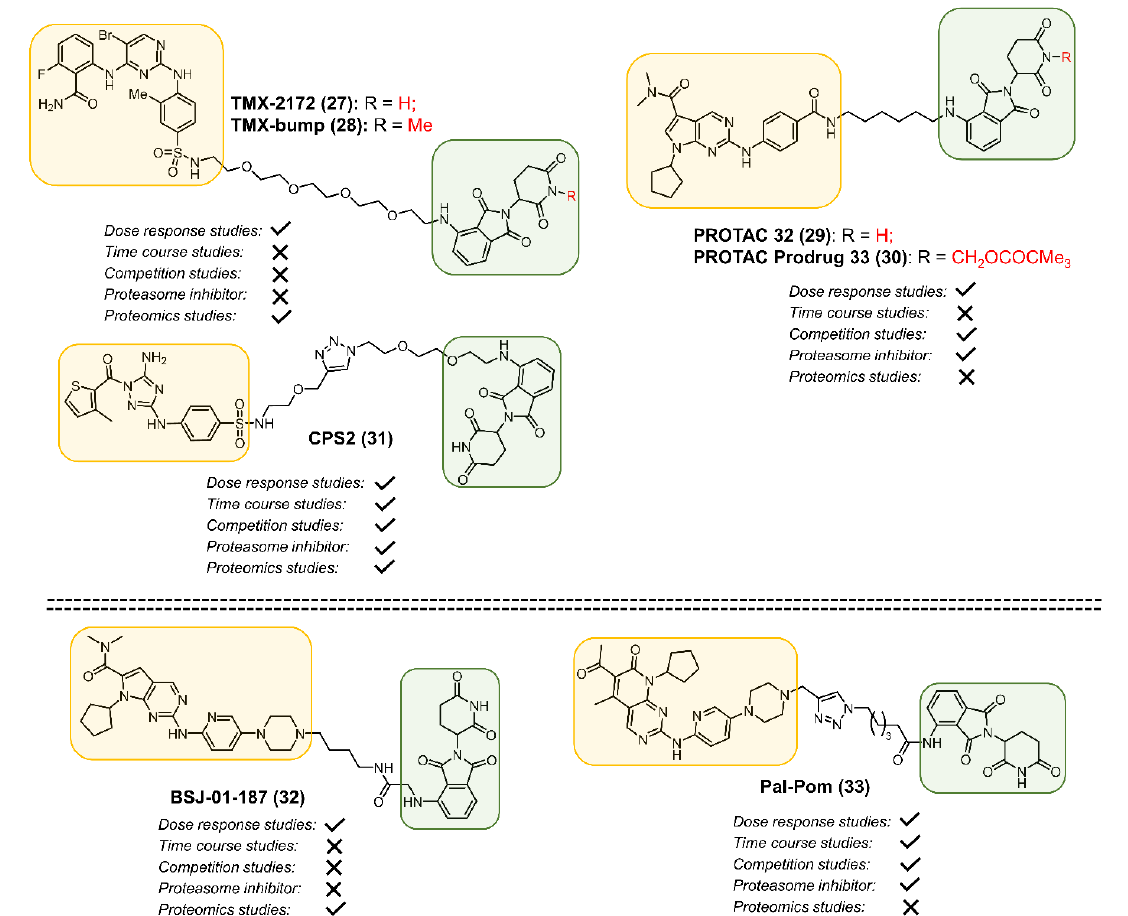
Figure 6. Structures of selective CDK2 ( 27 , 29 , and 31 ) and CDK4 ( 32 , 33 ) PROTACs.